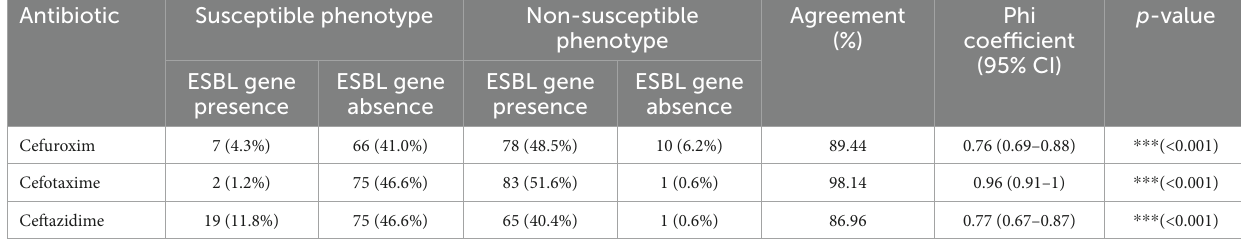
TABLE 1 Concordance between ESBL genotypes and cephalosporin phenotypes in Escherichia coli isolates from livestock.